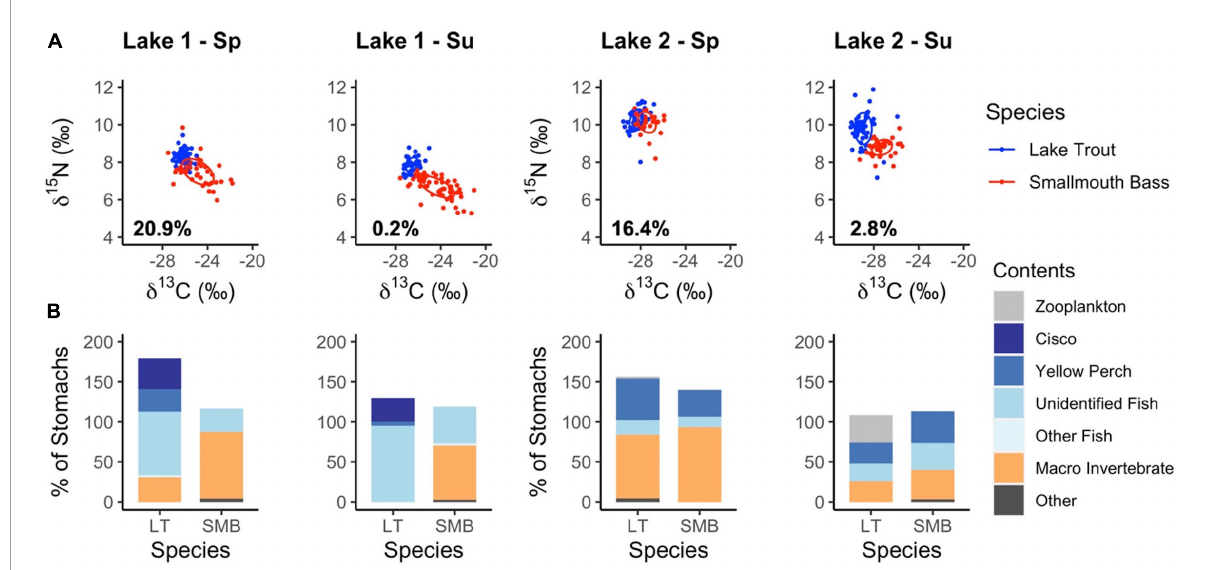
FIGURE5 Isotope biplot with ellipses where individuals have a 40% probability of being found, with the percent probability that a random lake trout will be in the isotopic niche space of smallmouth bass in the lower left corner (A) . The percent of non-empty lake trout and smallmouth bass stomachs that contained certain prey types (B) . Results are separated into spring (Sp) and Summer (Su) and Lake 1 (+ cisco) and Lake 2 (–